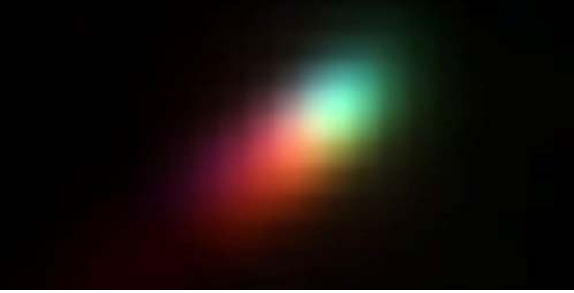
Figure 15. Superimposed images of 21 target centroids. All 21 images of one target in the lower left of the image field were superimposed and rendered in colour, by using the intensity in each monochrome image to modulate the sRGB triplet derived from the responses of the CIE colorimetric 2° observer for the corresponding filter wavelength. The resulting colour composite (Fig. 15) shows the comet-like distribution typical of chromatic aberration in most lenses. What is interesting is that the reversal of direction of the trajectory around 500nm is not obvious from this image; it looks rather as if the displacement is monotonic from cyan to